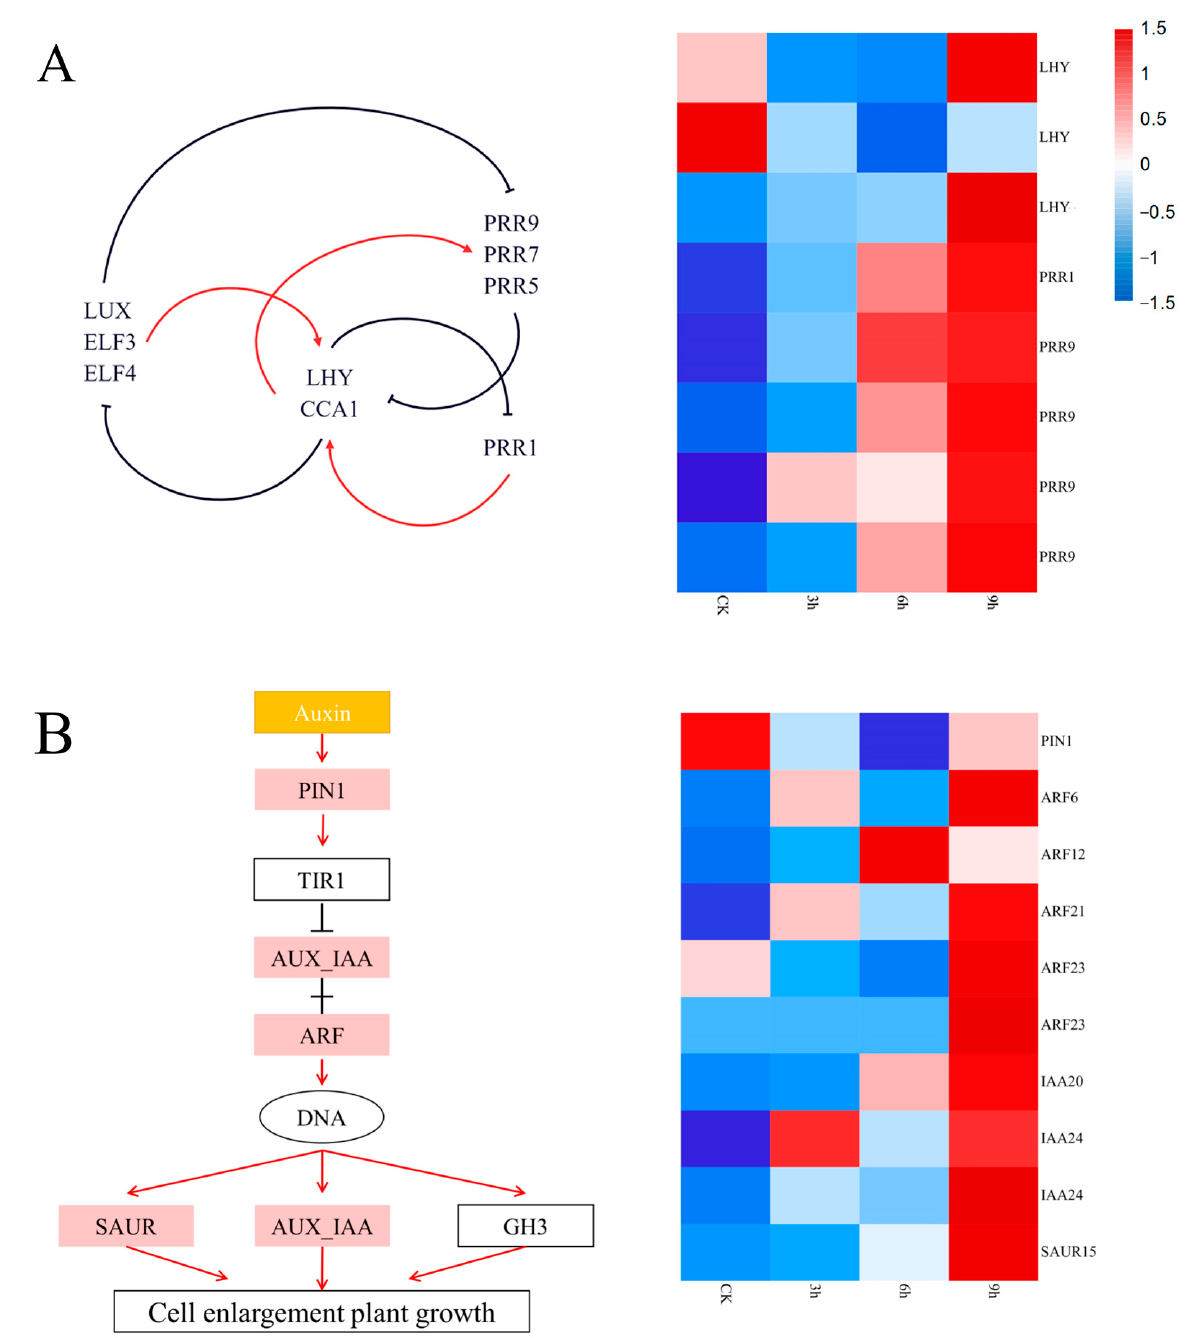
Figure 5. DEG involvement in different pathways in centipedegrass under low-temperature stress. ( A ) Central oscillator in the plant circadian rhythm pathway; ( B ) auxin polar transport and signal transduction pathway. The red arrow indicates activation and the black cutoff indicates inhibition.